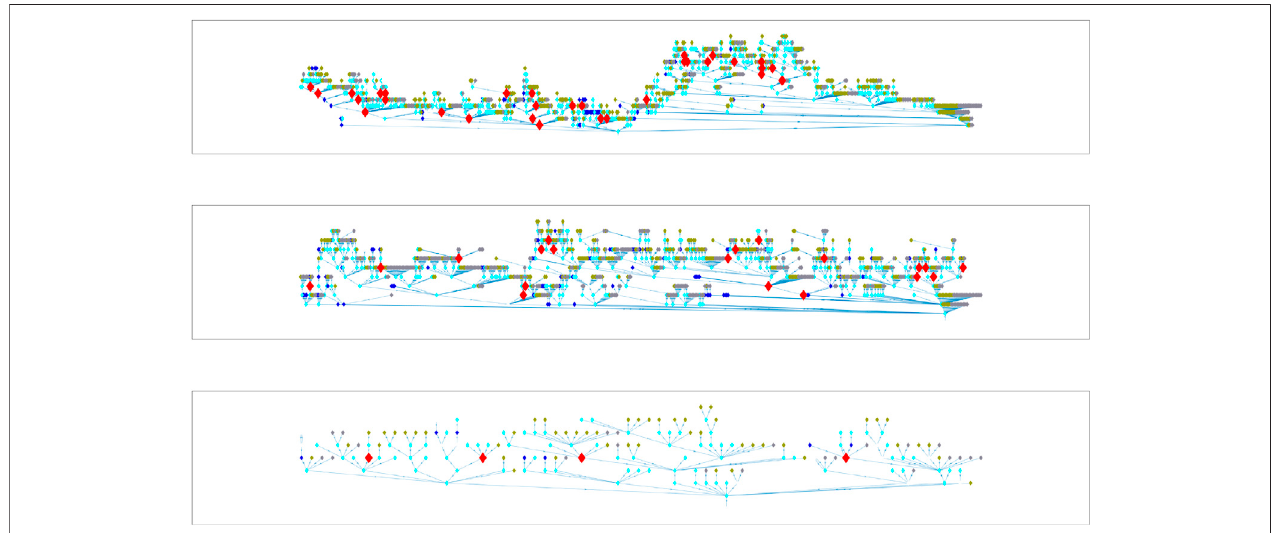
FIGURE 10 | The location of the critical water bodies in the network according to their in fl uent dependencies.